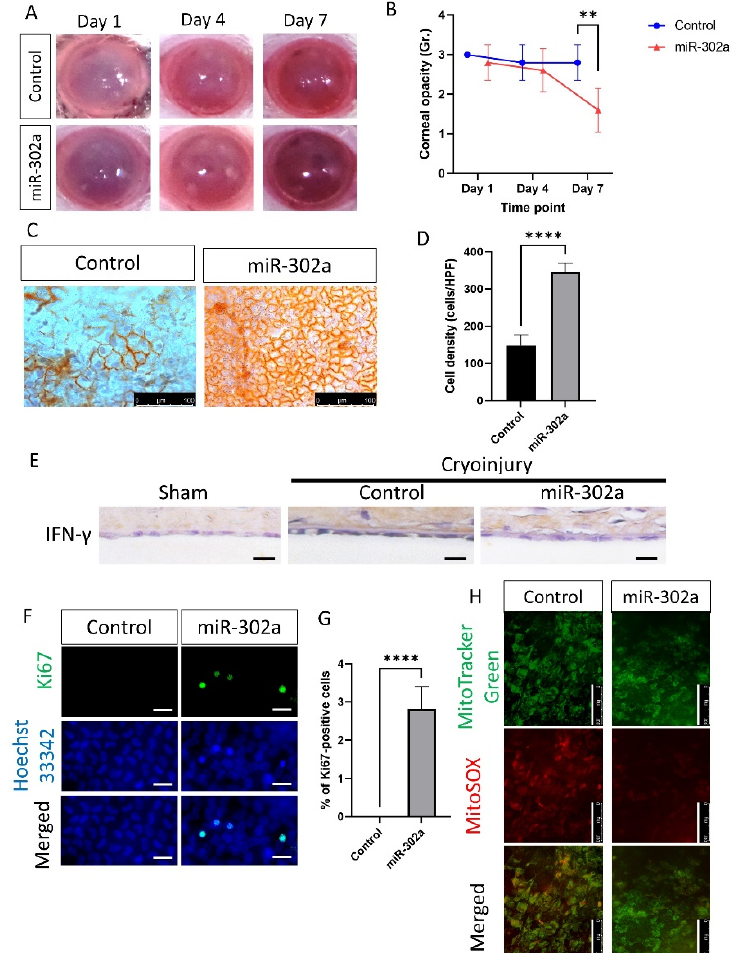
Figure 6. In vivo transfection of miR-302a and evaluation of corneal endothelium in rat. ( A , B ) Corneal opacity was evaluated in control and miR-302a group on day 7. ( C , D ) Alizarin S red staining showing corneal endothelium in control and miR-302a group on day 7. ( E ) Immunohistochemistry of IFN- γ was performed on the rat corneal endothelium. Scale bar = 25 µ m. ( F , G ) Immunofluorescence staining of Ki67 was performed in corneal endothelium of rats. Scale bar = 25 µ m. ( H ) MitoTracker green and MitoSOX staining was performed in corneal endothelium of rats in control and miR-302a group. Scale bar = 100 μ m. Data presented as mean ± S.D. ** p < 0.01 and **** p < 0.0001.